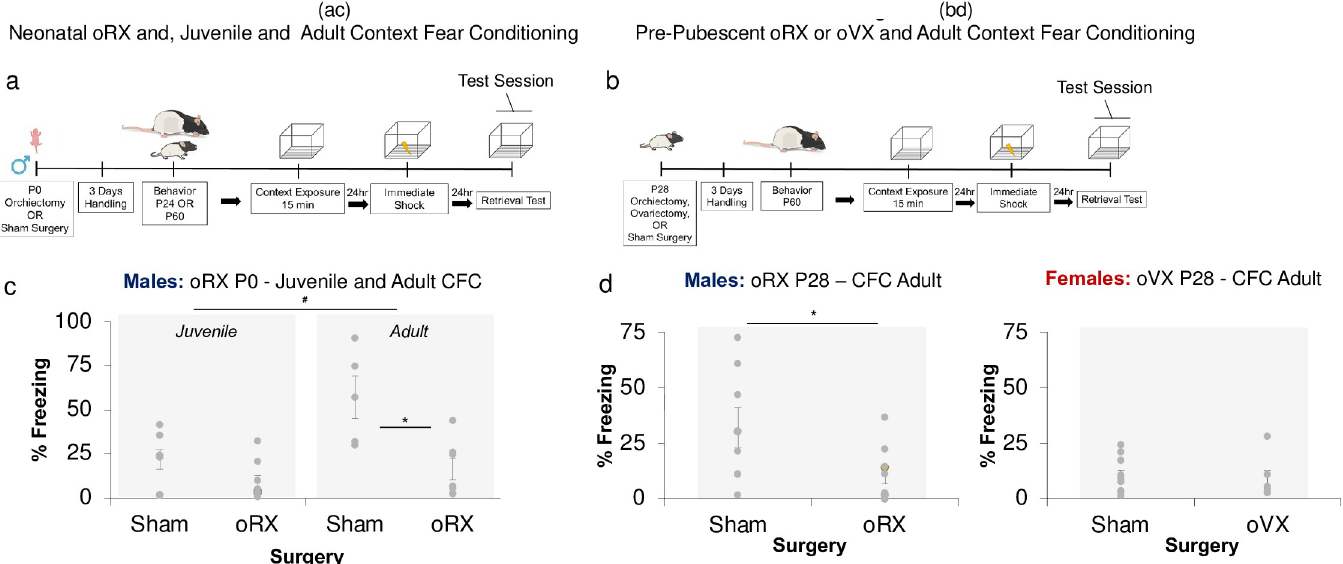
Fig 1. Deficits in adult context fear conditioning following neonatal and prepubertal oRX. Experimental timelines to examine the effects of ( a ) Neonatal orchiectomy on juvenile and adult male CFC and ( b ) pre-pubertal orchiectomy and ovariectomy on adult male and female CFC. ( c ) Removal of testes via oRX at birth significantly ( � p < .05) reduced freezing in adults, but not in juvenile rats (n = 5-9/group). Overall, conditioning was greater in adults than in juvenile rats ( � p < .05). ( d ) oRX performed days before puberty similarly reduced CFC in adulthood ( � p = .05), while removal of ovaries via ovariectomy (oVX) days prior to puberty did not yield a significant difference in conditioning (n =